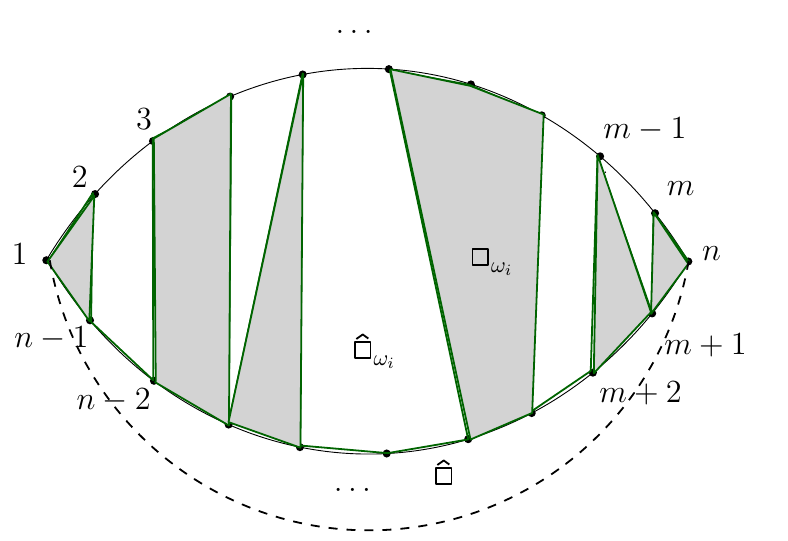
Figure 9 . A \random walk" from 1 to n . Recall that 2 !